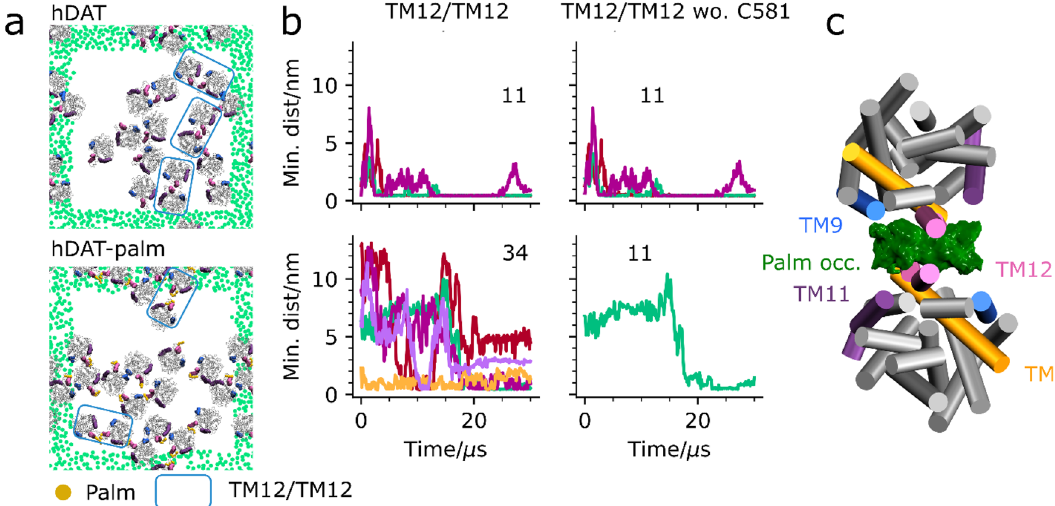
Figure 5. Dynamics of the TM12/TM12 interface. In ( a ) the last frame of a single representative repeat simulation is shown for hDAT (MD2, top) and hDAT-palm (MD3, bottom). The last frames for all repeat simulations are supplied in Supplementary Fig. S1. Similar interfaces are observed across the two systems involving TM12 on which palm (orange) is attached. Within the blue box a TM12/TM12 interface is observed. The green dots correspond to the GL1 bead in POPC and are shown for the nearest periodic images to the system. For the single simulation box the dots have been omitted. The helices TM9, TM11, and TM12 are highlighted in blue, purple and mauve, respectively. In ( b ) the formation of single TM12/TM12 contacts both considering and not considering Cys581 (wo. Cys581) on which palm is attached in the analysis. The TM12/ TM12 pairs that were monitored were evaluated as being in contact continuously for 500 ns during the course of the simulation. A contact was defined when the minimum distance between TM12 helices was below 7 Å. The contact plots for the different interfaces across all repeat simulations are supplied in Supplementary Fig. S15-17. Shown in ( c ) is the palm 3D occupancy computed using the Volmap plugin in VMD for all dimers captured in the TM12/TM12 hDAT-palm cluster (cluster 53 in Table